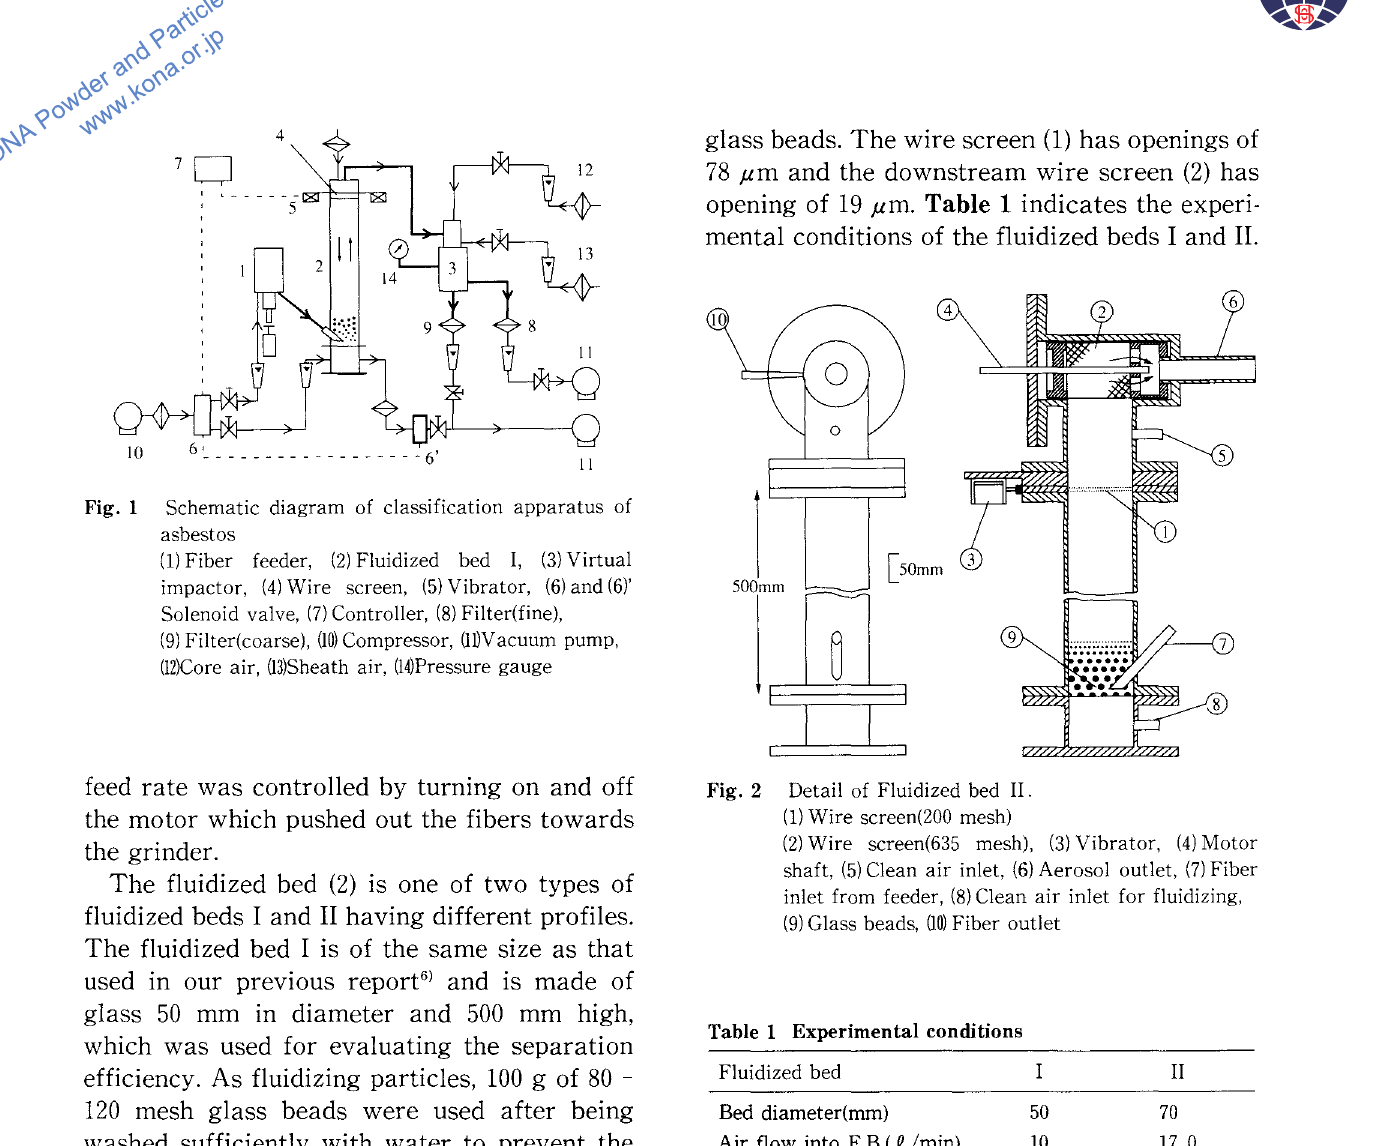
Schematic diagram of classification apparatus of